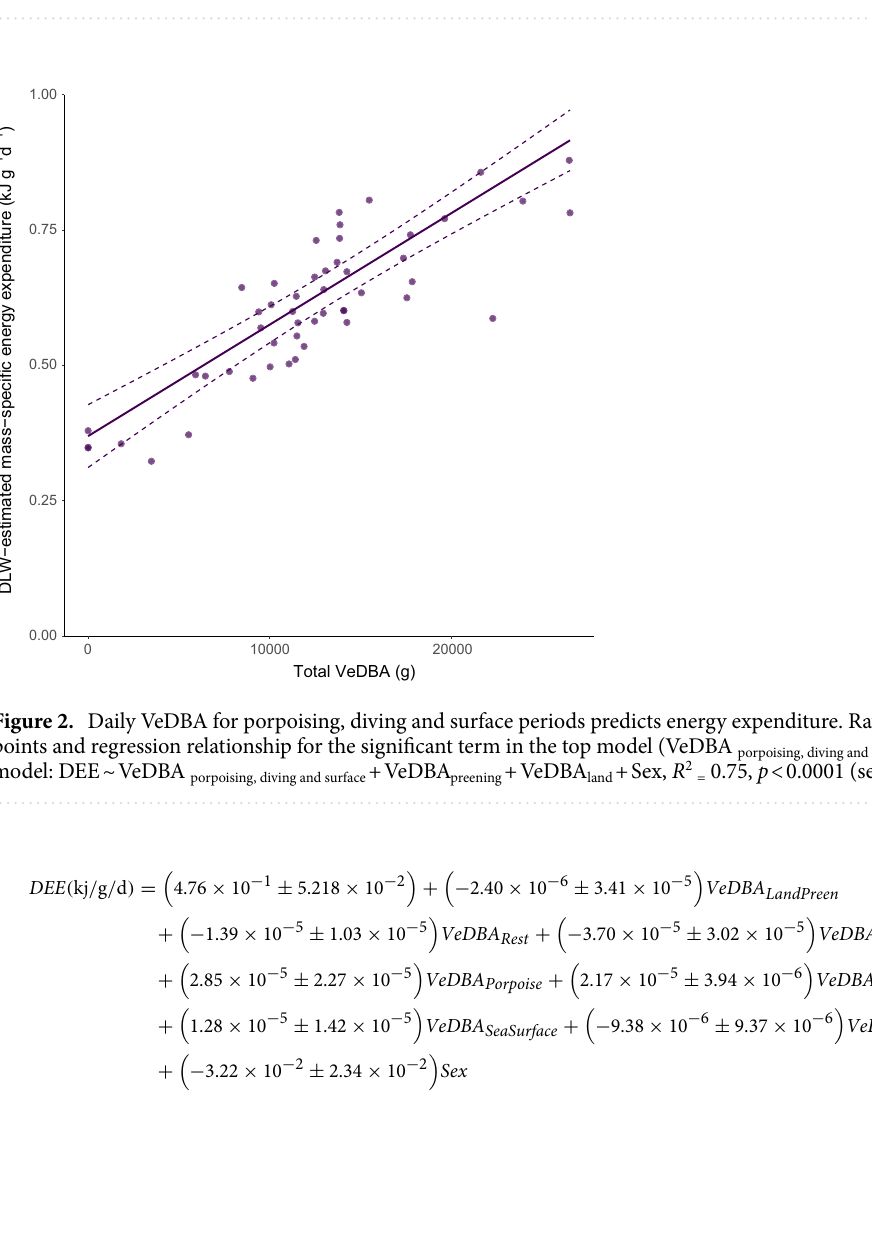
Table 1. Comparisons among models for explaining energy expenditure in wild Adélie penguins in behavioural modes. We considered all potential time budget and dynamic body acceleration (DBA) models. We present all models with Δ AIC < 2 compared to the best model, as well as three null models: two different time budget models and the model only including average VeDBA across all behavioural modes. Null models are denoted with asterisks.